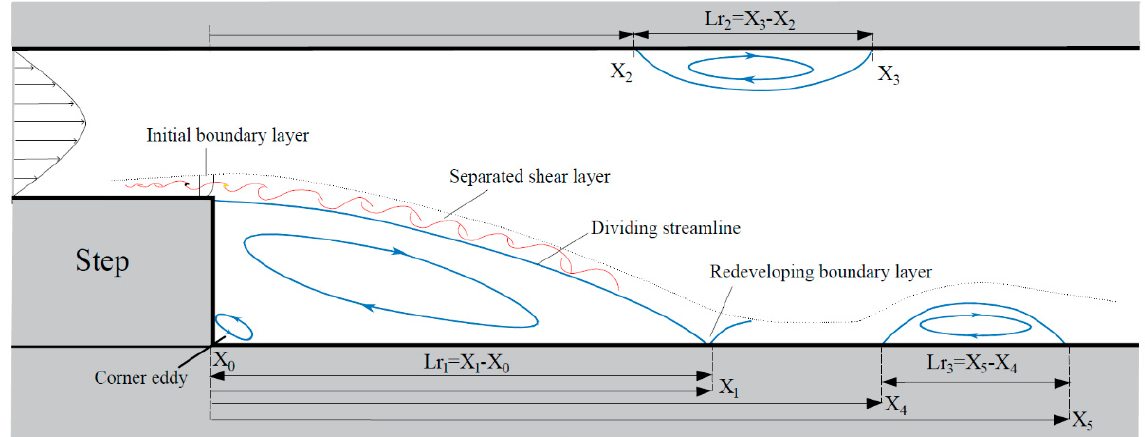
Figure 4. Sketch of the flow over the backward-facing step.